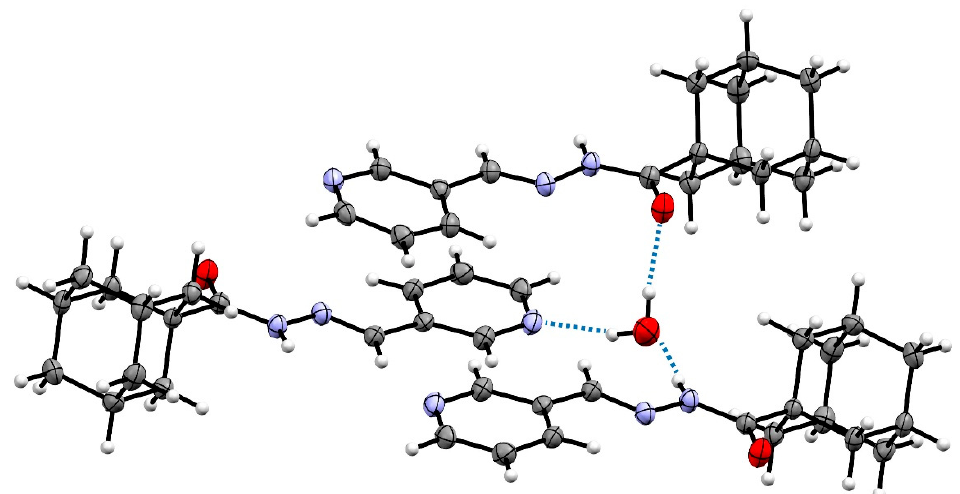
Figure 2. Hydrogen bond (blue dashed line) scheme for compound 1 . Atom color code: C (grey), H (white), O (red), N (blue), S (yellow).